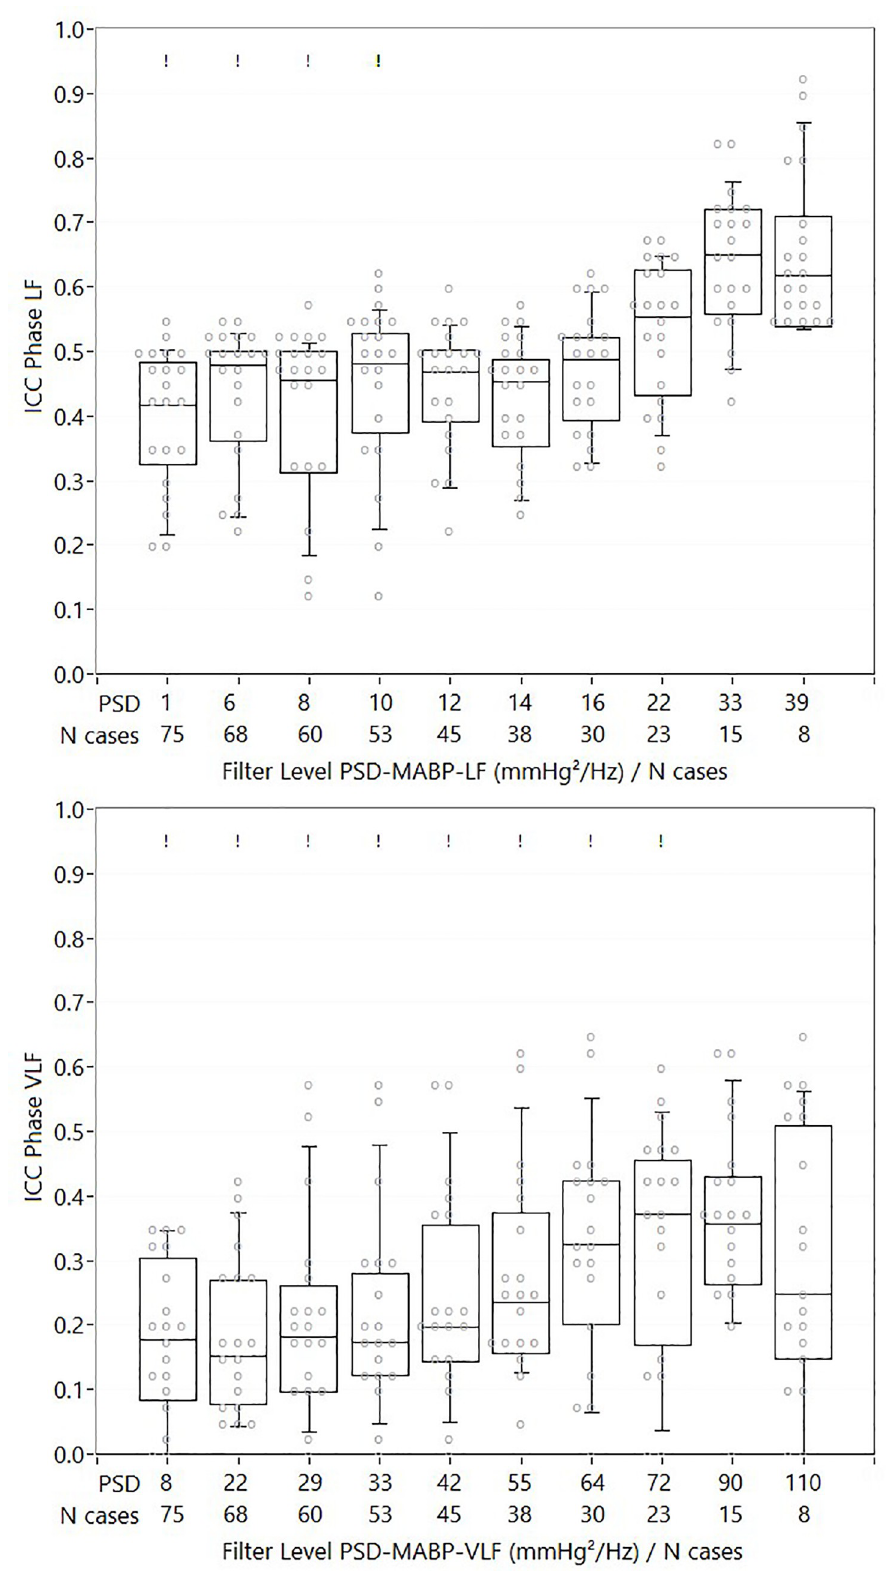
Fig 4. ICC values for phase LF and phase VLF. Beeswarm boxplot with ICC values for phase LF (upper figure) and phase VLF (lower figure) for different cut-off levels of PSD-MABP. Each grey dot represents an analysis method. ! :